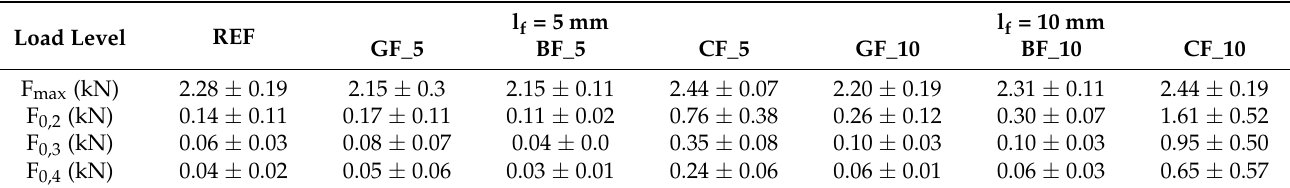
Table 6. The average of maximum loads and post-cracking loads at selected deflections.